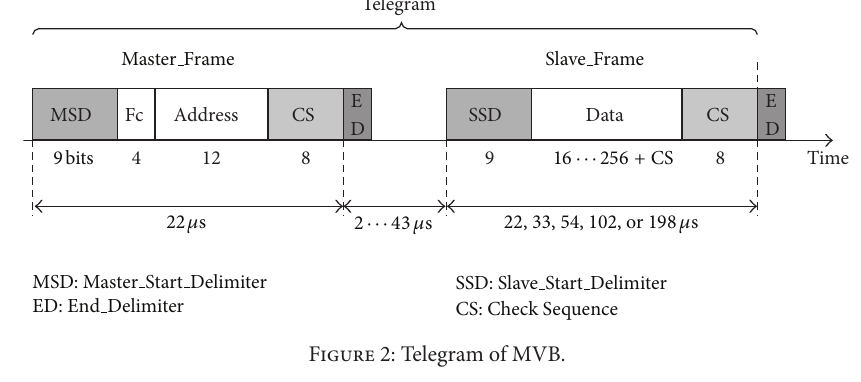
Figure 2: Telegram of MVB.